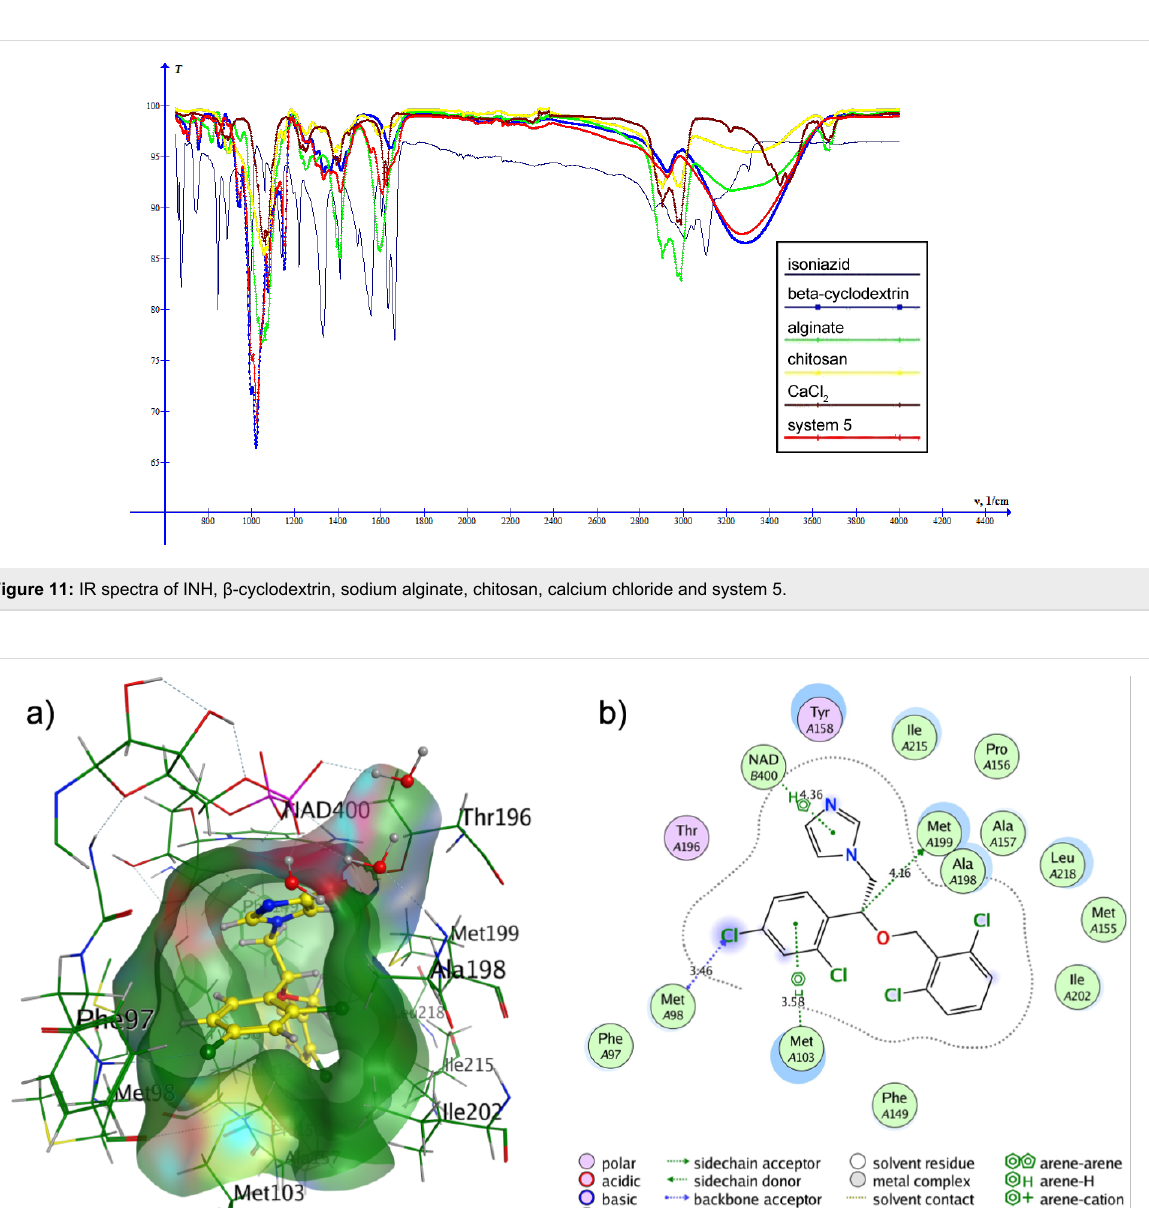
which produced media concentrations of active compounds of 5–10 mg/mL, proved to be as effective as pure isoniazid at 100 mg/mL against M. tuberculosis H37Rv in culture. The mor- phology of the obtained particles varies from spherical to irreg- ularly-shaped with sizes ranging from 0.1 to 250 μ m. The FTIR spectra analysis revealed molecular interactions between active compounds and the cyclodextrin–polymer moieties of the parti- cles. Isoconazole was predicted as an active inhibitor of InhA after the analysis of the molecular docking and electron density